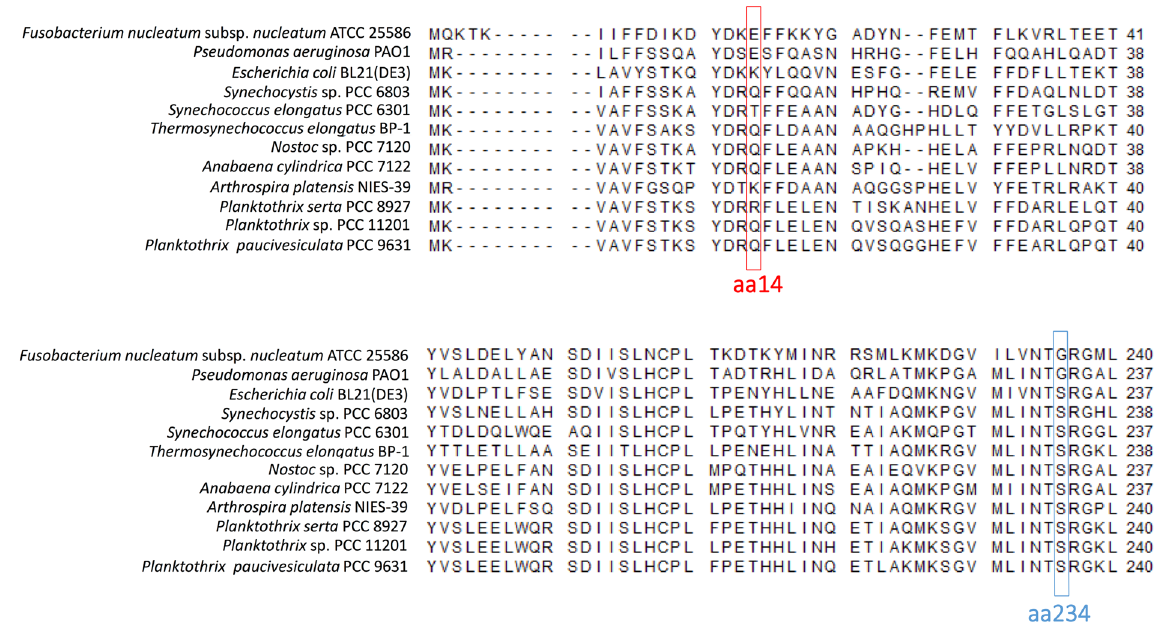
Figure 3. Multiple alignment of Ddhs from cyanobacteria and Gram-negative bacteria. The multiple protein sequence alignment was performed using CLC Sequence Viewer. The amino acid residues at positions 14 and 234 of Sy Ddh and equivalent residues of the other Ddhs are marked in red and blue, respectively.